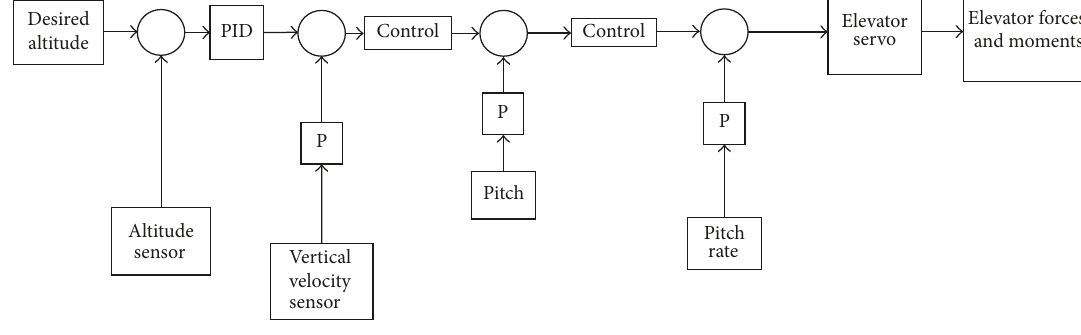
Figure 5: Altitude hold autopilot.